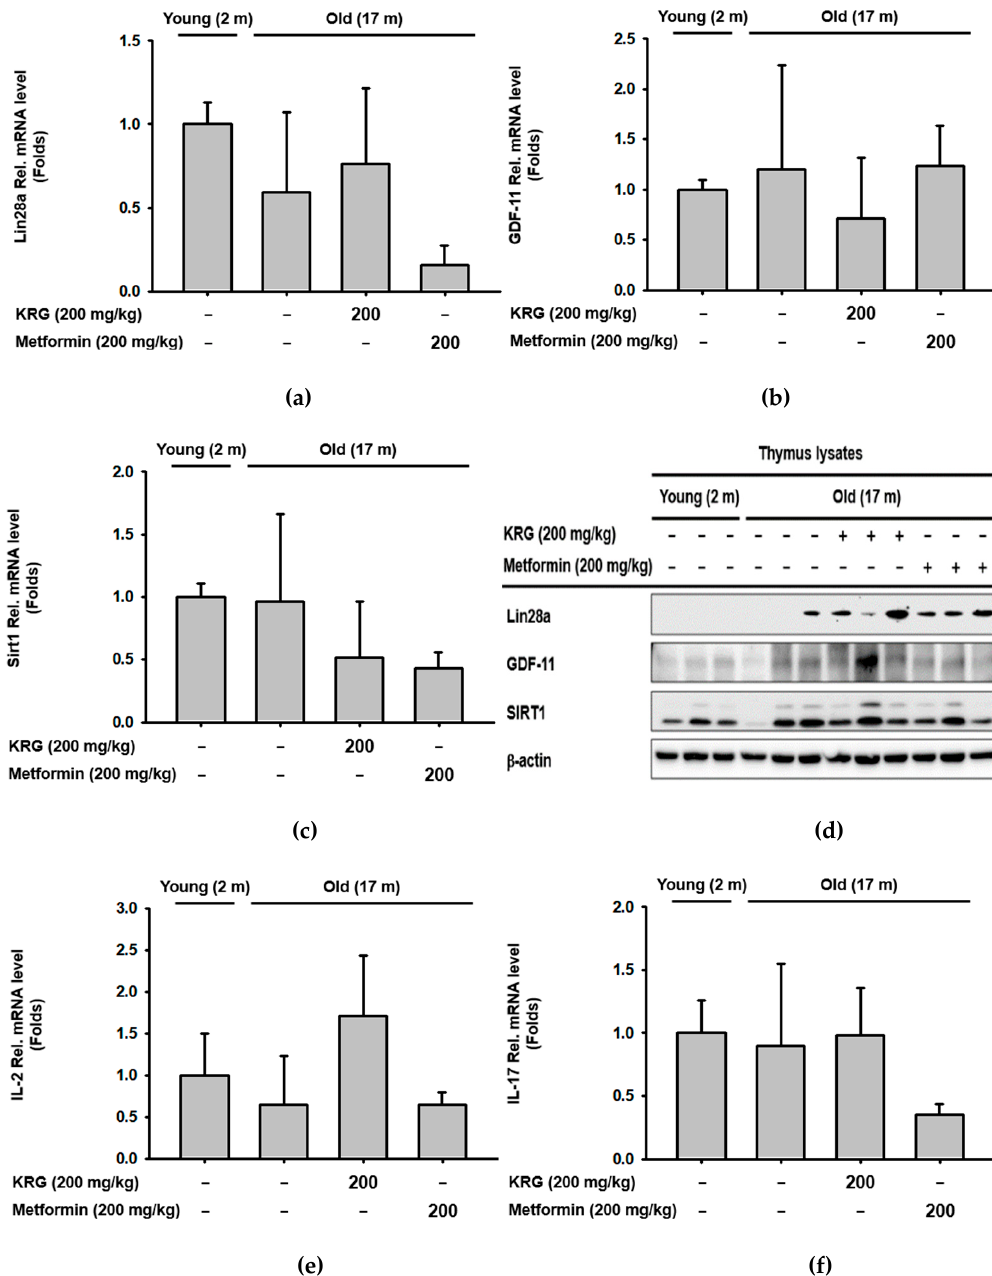
Figure 2. KRG did not alter the expression of aging-related genes in aged mice. ( a–c ) mRNA expression of Lin28a, GDF-11, and Sirt1 in the thymocytes of young and old mice dosed with KRG (200 mg / kg) or metformin (200 mg / kg) was determined using quantitative real-time PCR. ( d ) Protein expression of Lin28a, GDF-11, and Sirt1 in the thymocytes of young and old mice dosed with KRG (200 mg / kg) or metformin (200 mg / kg) was determined using Western blot analysis. ( e , f ) mRNA expression of IL-2 and IL-17 in the thymocytes of young and old mice dosed with KRG (200 mg / kg) or metformin (200 mg / kg) was determined using quantitative real-time PCR.